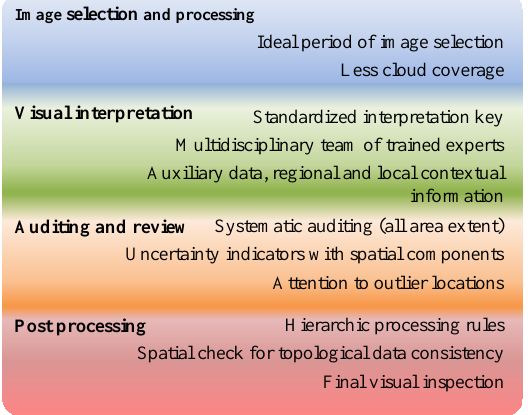
Figure 6 - Scheme of methodological steps developed to map non-forest removal in the Brazilian Amazon biome.